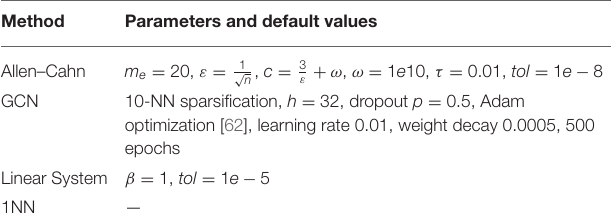
TABLE 2 | Default parameters used in the